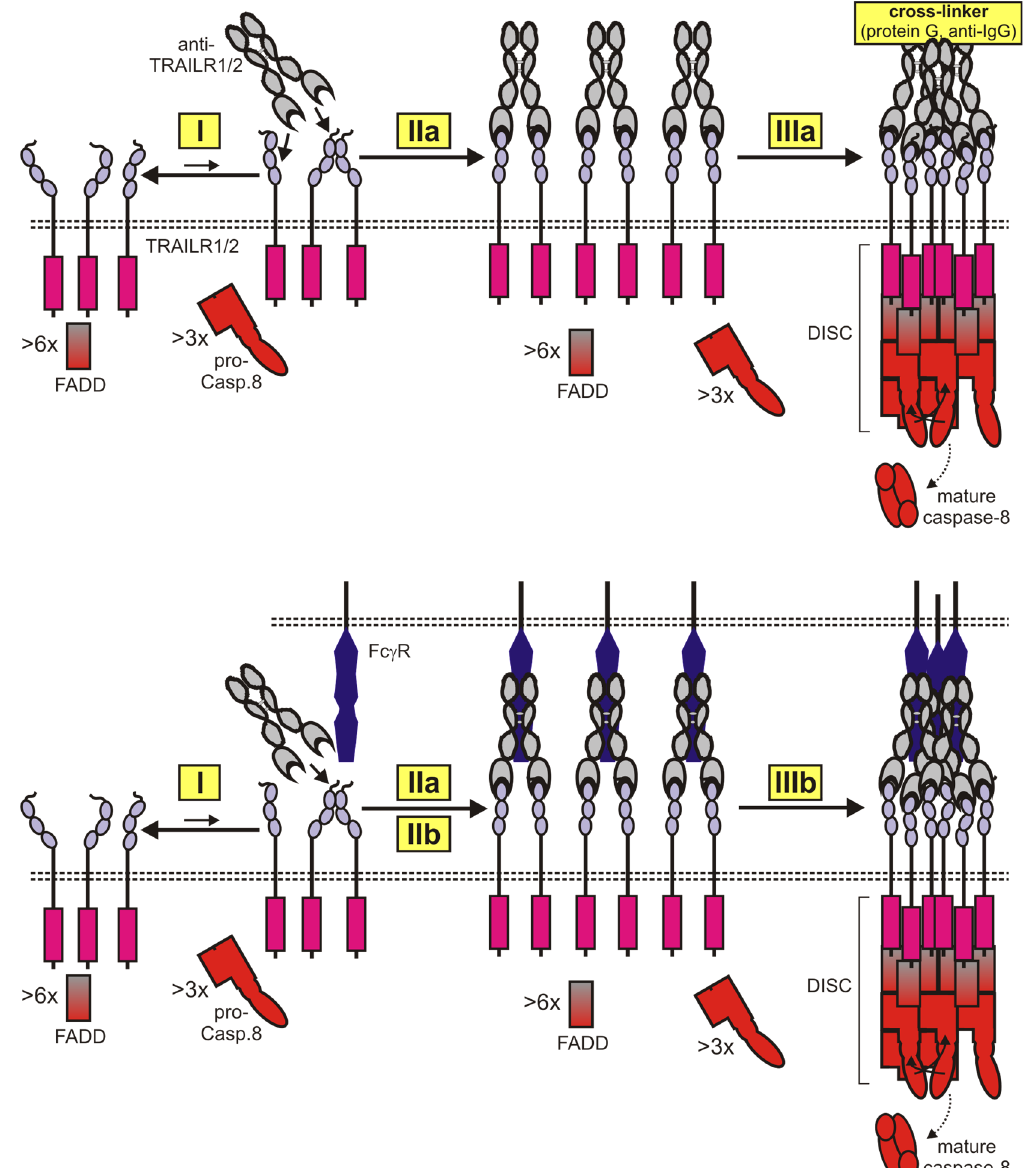
Figure 4. Two-step formation of apoptotic TRAIL death receptor-signaling complexes by bivalent TRAIL death receptor antibodies. In the absence of antibody, TRAIL receptors presumably occur in a dynamic equilibrium of monomeric and dimeric (or trimeric) receptor species (I). A TRAIL death receptor antibody binds with high-affinity two-receptor molecules. This complex is largely inactive and typically does not cluster (IIa). In the presence of Fc γ R-expressing cells, the antibodies may bind concomitantly to the targeted TRAIL death receptor and Fc γ Rs (IIb). Dimeric antibody-TRAILR1/2 complexes cluster secondarily to active oligomeric networks either due to physical crosslinking of the antibodies (IIIa) or due to the high local concentrations generated by Fc γ R binding.